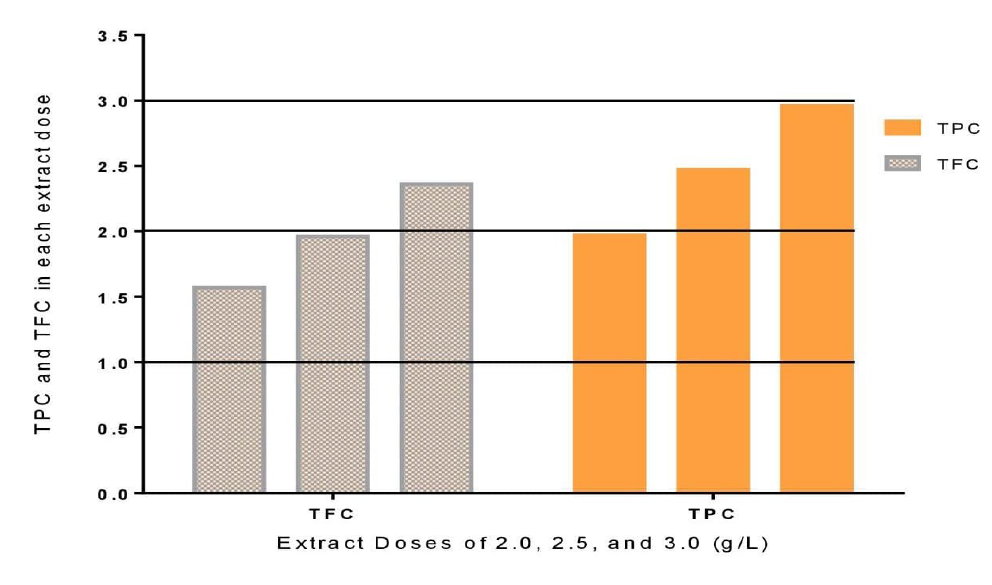
Figure 2 : TPC and TFC in P. ligularis (granadilla) extract doses in drinking